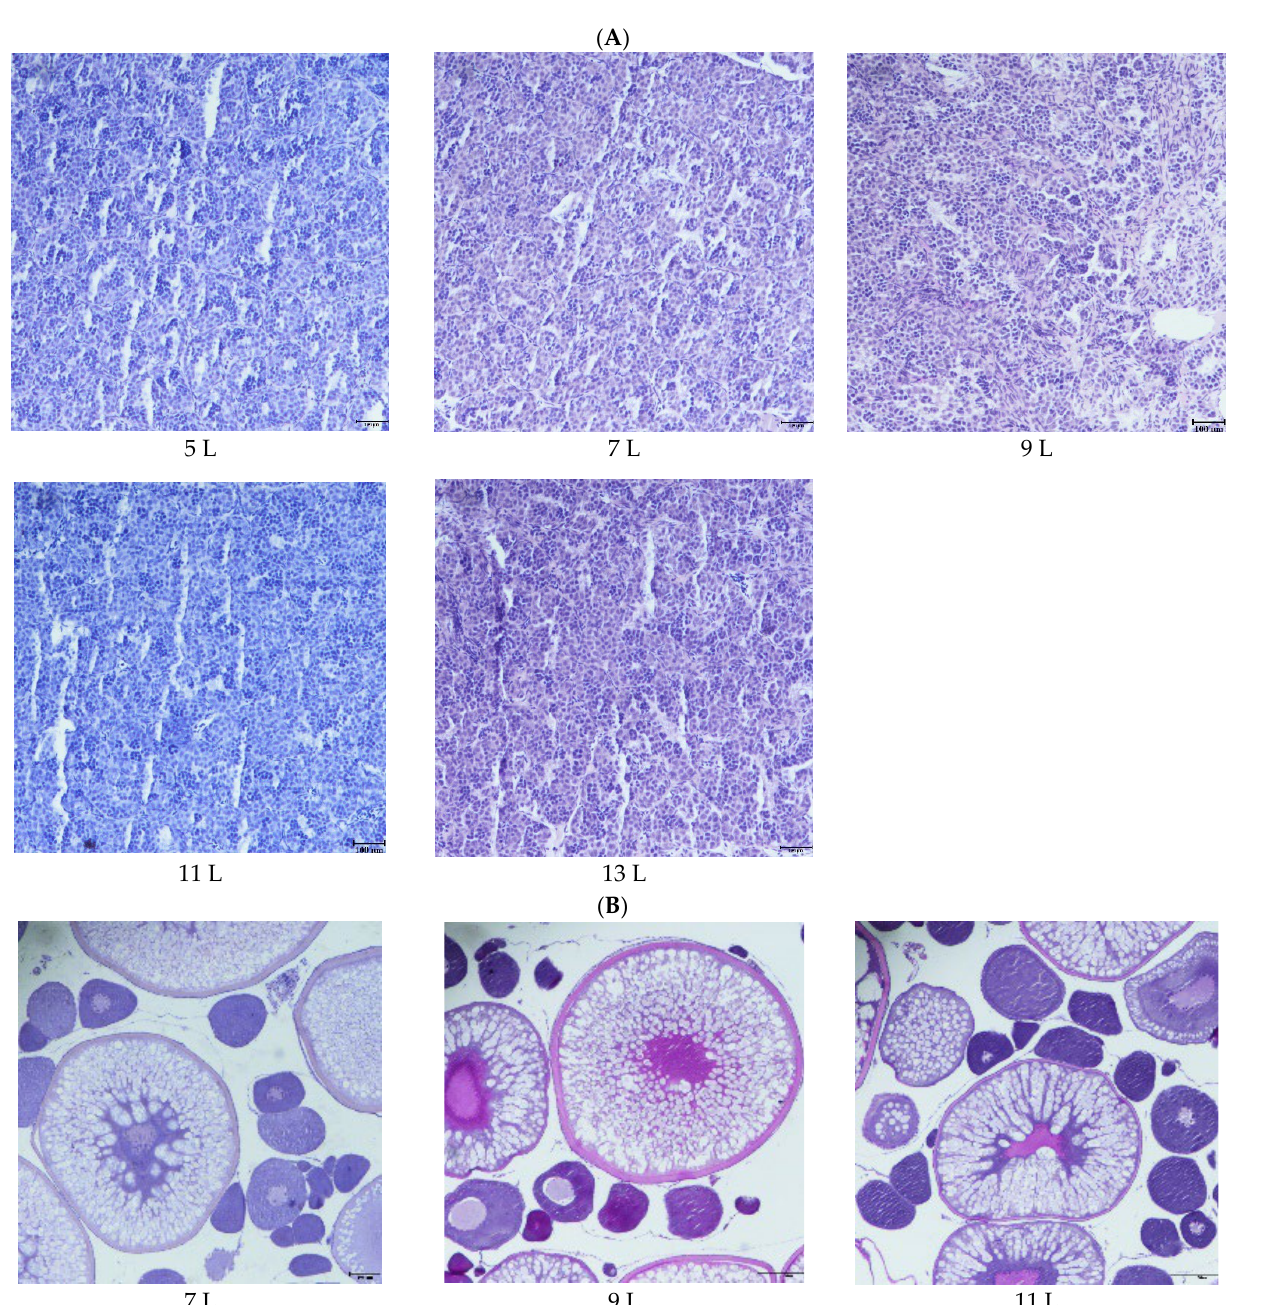
Figure 1. Histological section of the testis and ovary of the male and female O. macrolepis broodstock, fed graded lipid levels during 8 weeks of feeding trial. (Testis, 100 × magnification ; ovary, 40× magnification; bar = 100 μm). Here only show histological section of the ovary in 7 L, 9 L and 11 L groups. ( A ). Gonad of male (testis); ( B ). Gonad of female (overy).